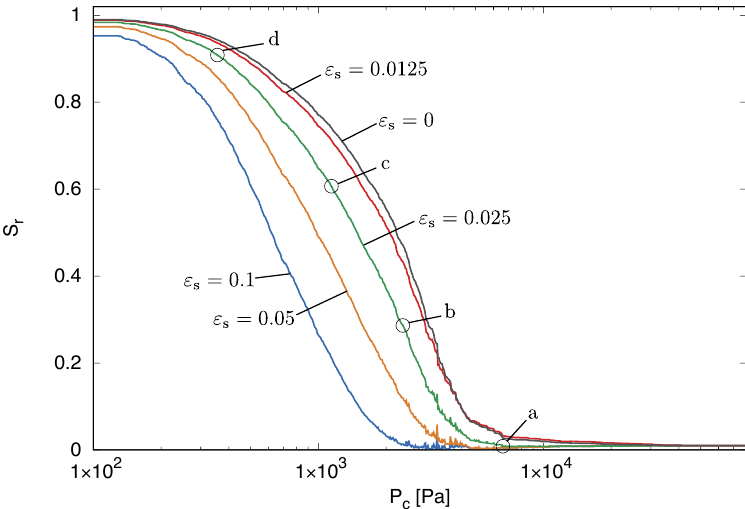
Figure 7. Constrained swelling analysis: retention in the form of saturation S r versus capillary suction P c . The labels a, b, c and d mark stages at which the spatial distribution of quantities within the cell is